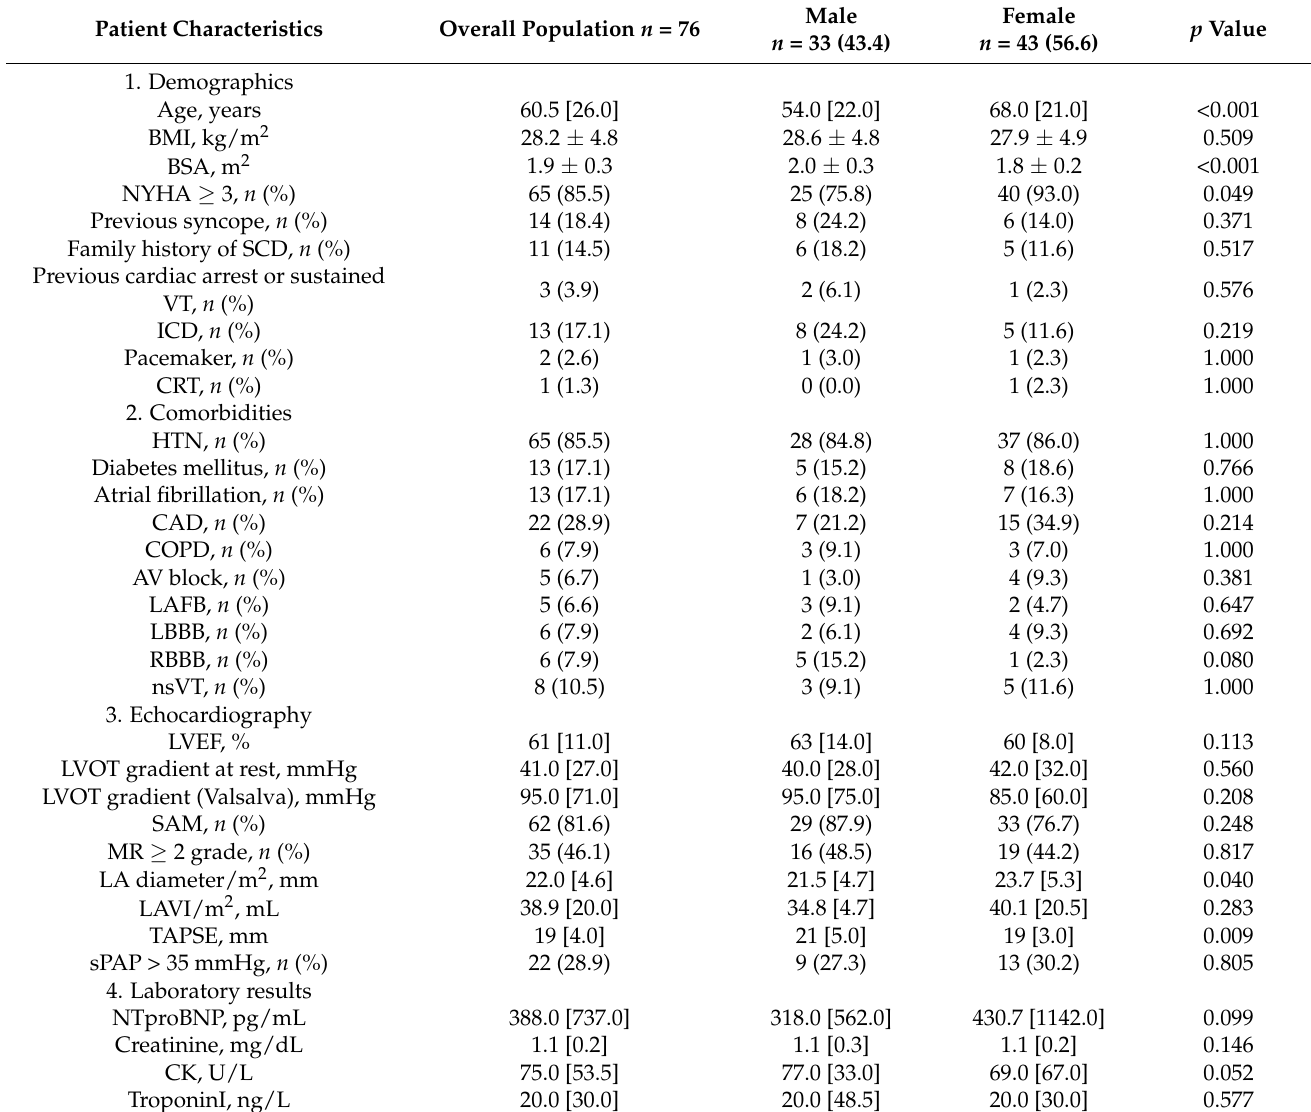
Table 1. Baseline characteristics of the patient